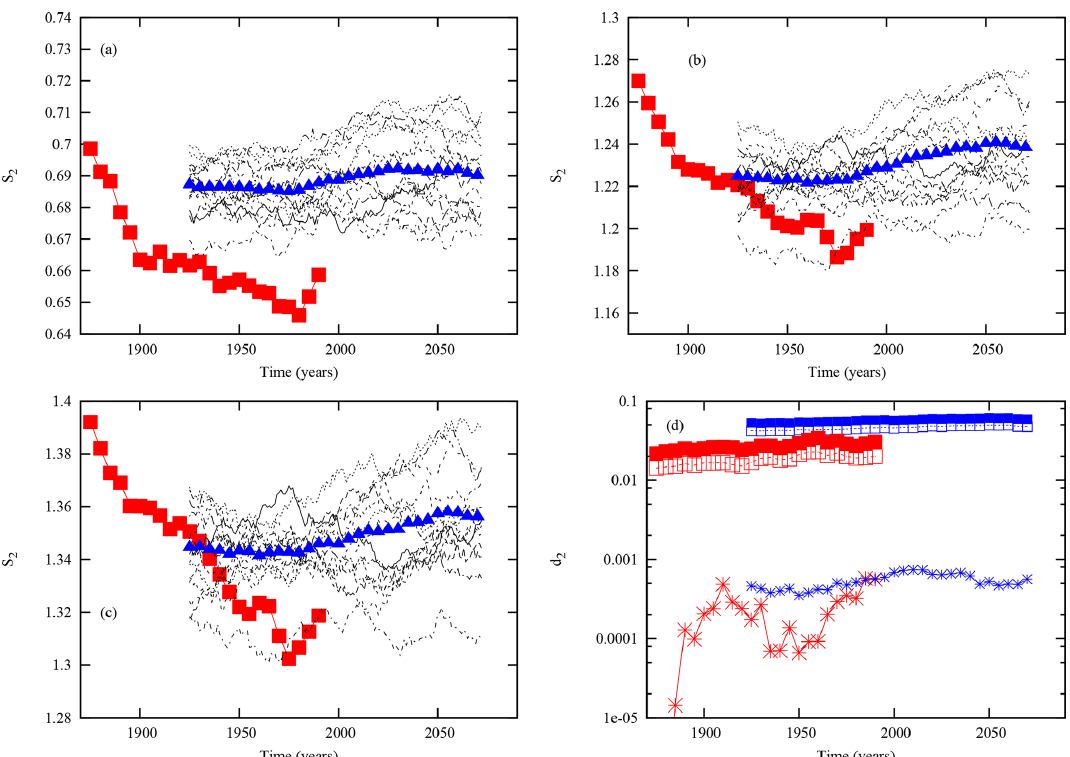
Figure 4. Temporal evolution of S 2 for the 15 model runs of the Met Office model from 1900 to 2099 under the RCP2.6 scenario (black lines), for (a) three patterns, (b) six patterns, and (c) eight patterns. The red curves represent the reference historical data and the blue triangle curve the average entropy over the 15 runs. (d) The lower bound of the information entropy production, d 2 , for the three regime partitions for the observations (red) and for the average information entropy production of the model runs (blue). The different symbols (star, open square, full square) correspond to the three partitions three, six and eight patterns,